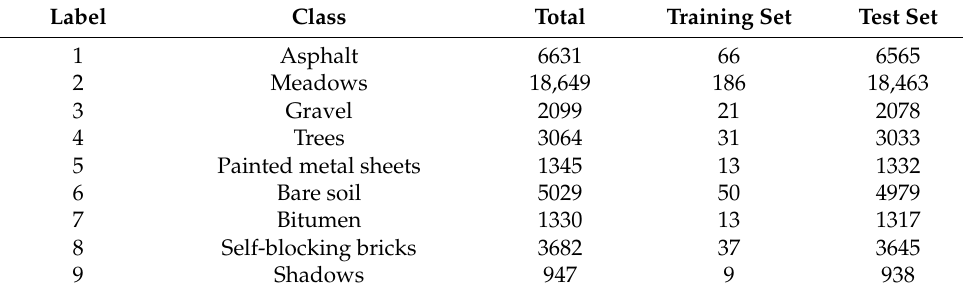
Table 3. Number of training and test samples for the PU dataset. Label